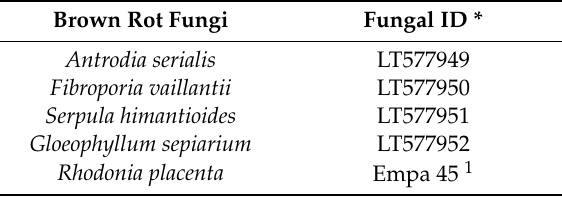
Table 1. Origin of fungal species used in the present